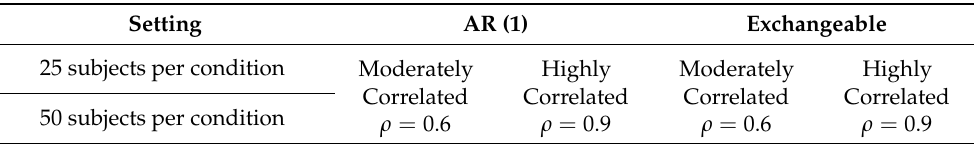
Table 1. Summary of parameter settings for the simulation studies. Two correlation structures, AR (1) and exchangeable were generated. Setting